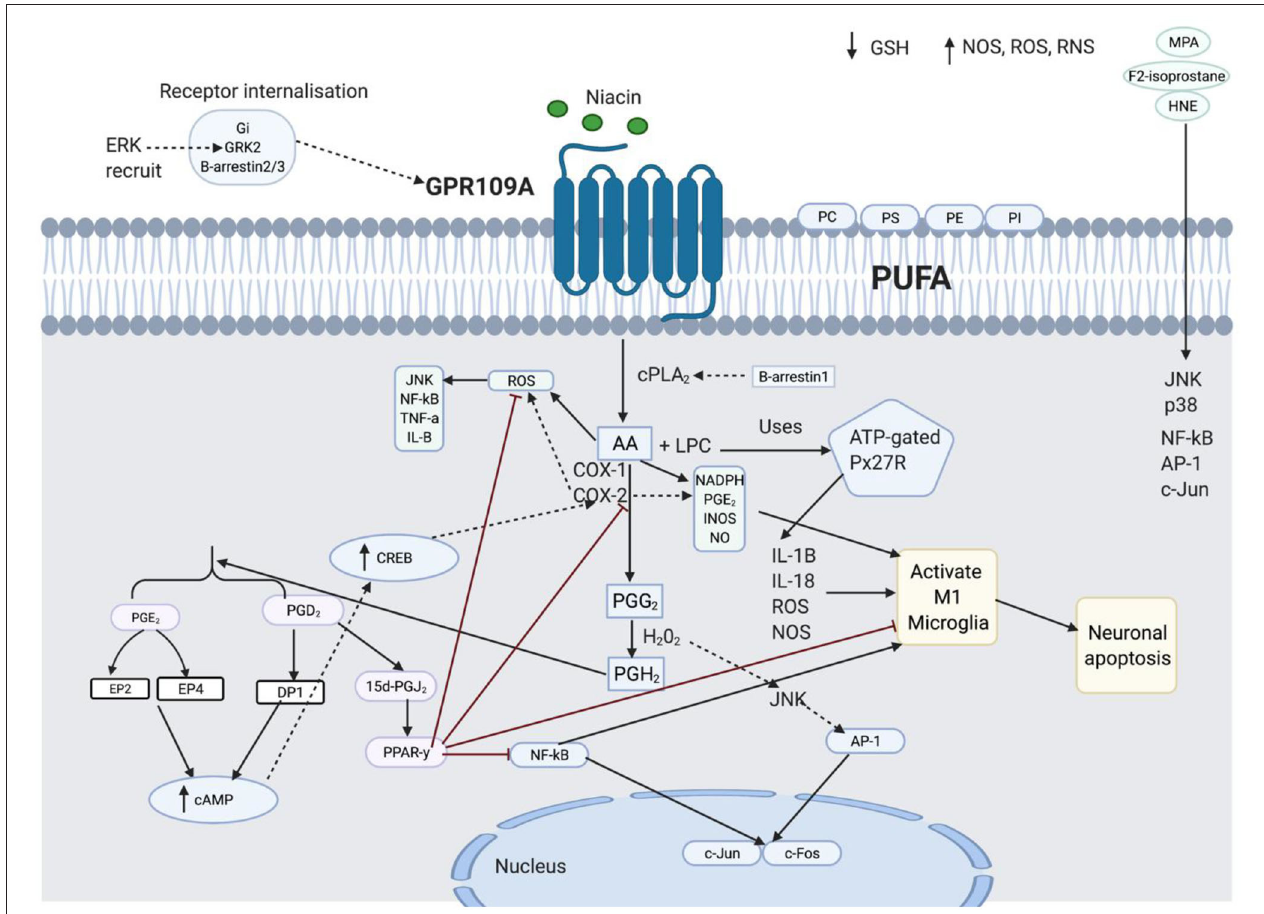
FIGURE 8 | This figure shows the spider-web of inflammation involved in diminished flush response. The details are separated into four subheadings: lipid peroxidation and inflammation, the role of 15d-prostaglandin J 2 (15d-PGJ 2 ) and peroxisome proliferator-activated receptor-y (PPAR γ ) in anti-inflammation, Transduction Signal role in GPR109A components, and Function of enzymes in diminished flush response and